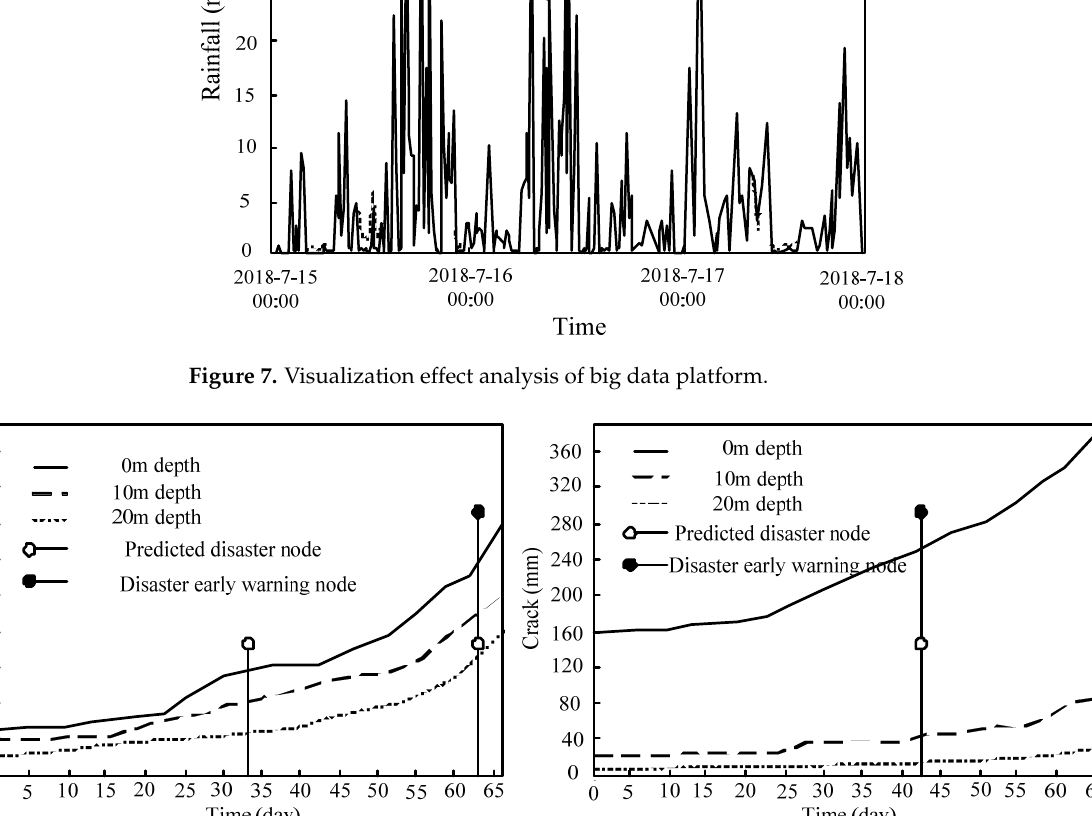
Figure 7. Visualization effect analysis of big data platform.